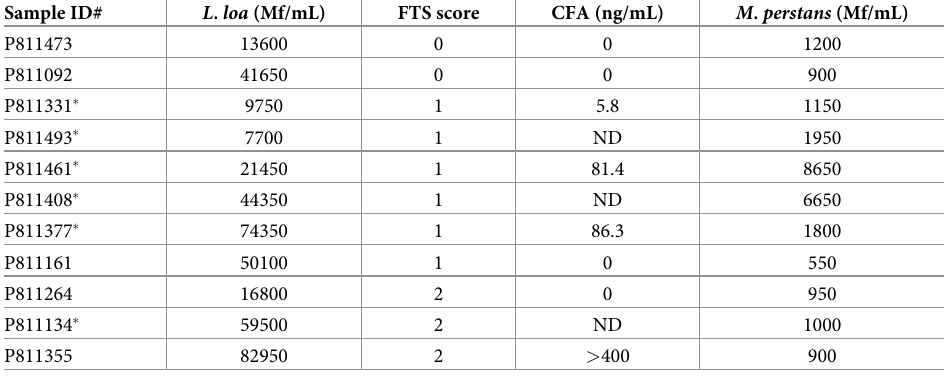
Table 2. Summary of Mf burden and antigenemia in ICT/FTS cross-reactive L . loa infected individuals from East Region Cameroon mapping